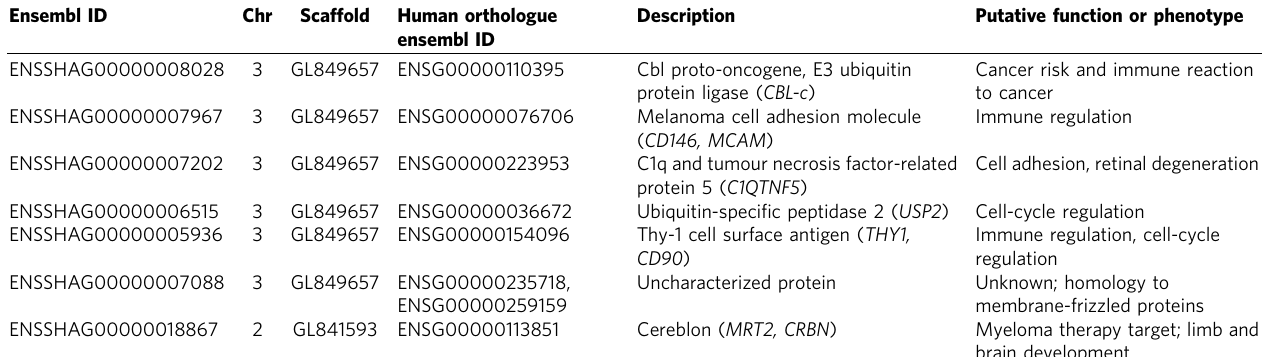
Table 1 | The seven candidate genes found in or closest to regions with concordant signatures of selection. Ensembl